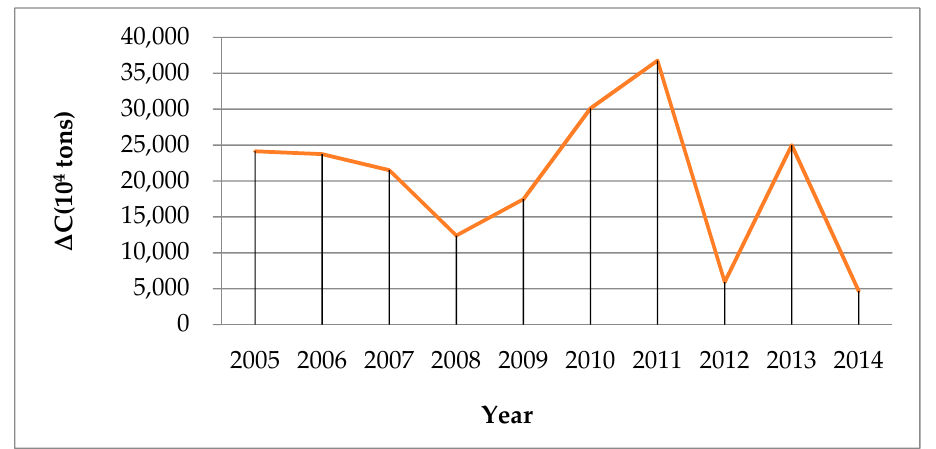
Figure 3. The increment of carbon emissions ( Δ C) from 2005 to 2014.